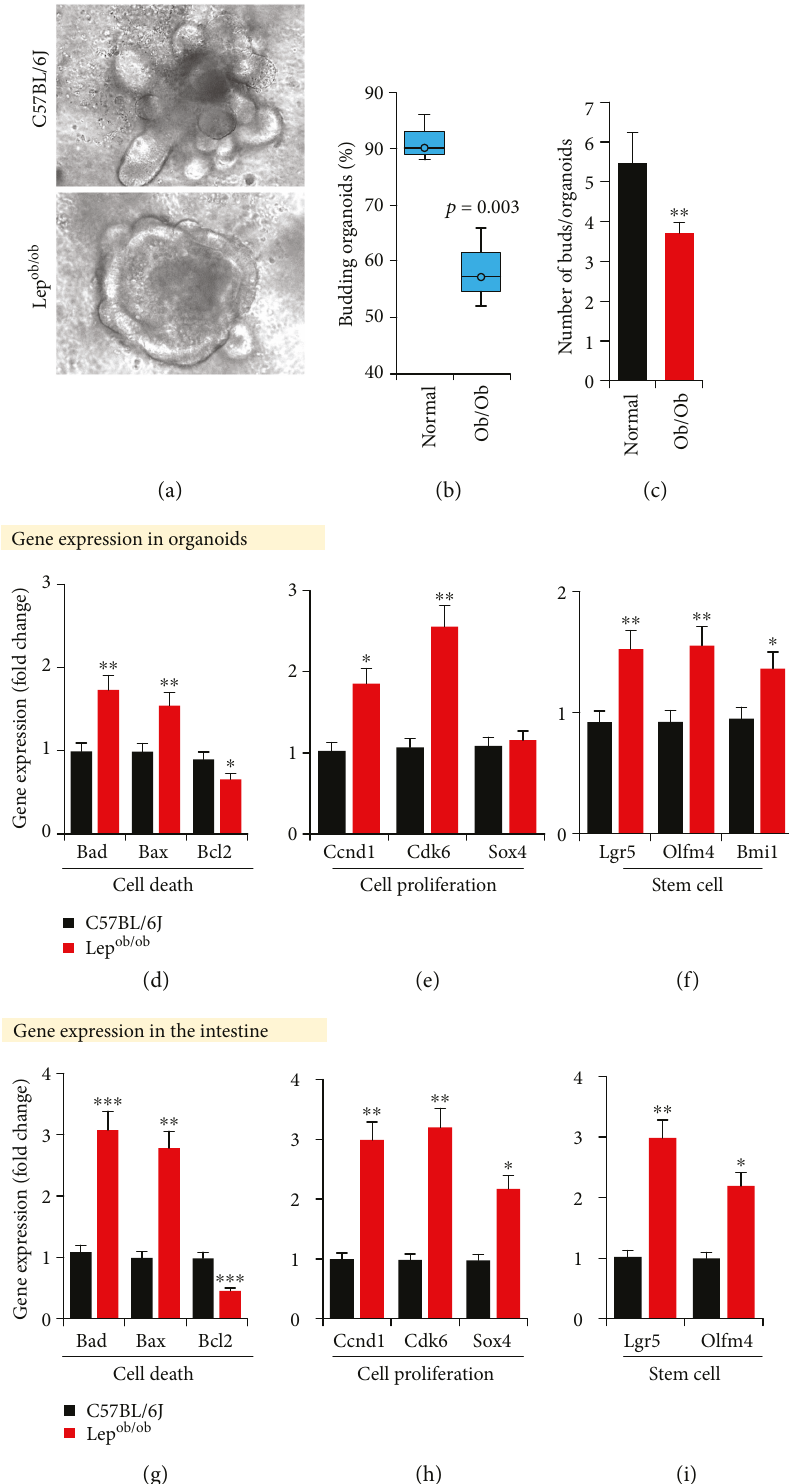
Figure 2: Non-diet-induced obesity developed stable changes in cells to form abnormal intestinal structures and in fl uenced intestinal cellular homeostasis. (a – c) Intestinal organoids (a) and their budding potential (b, c) decreased in Lep ob/ob -derived organoids versus B6 mice. (d – i) mRNA expression of cell death ( Bad , Bax , and Bcl2 ), cell proliferation (Ccnd1, Cdk6, and Sox4), and stem cell- (Lgr5-, Olfm4-, and Bmi1-) speci fi c genes in obese and B6 intestines. Values presented here are average ± SEM/SD. p values are de fi ned as ∗ < 0 05 , ∗∗ < 0 01 , and ∗∗∗ < 0 001